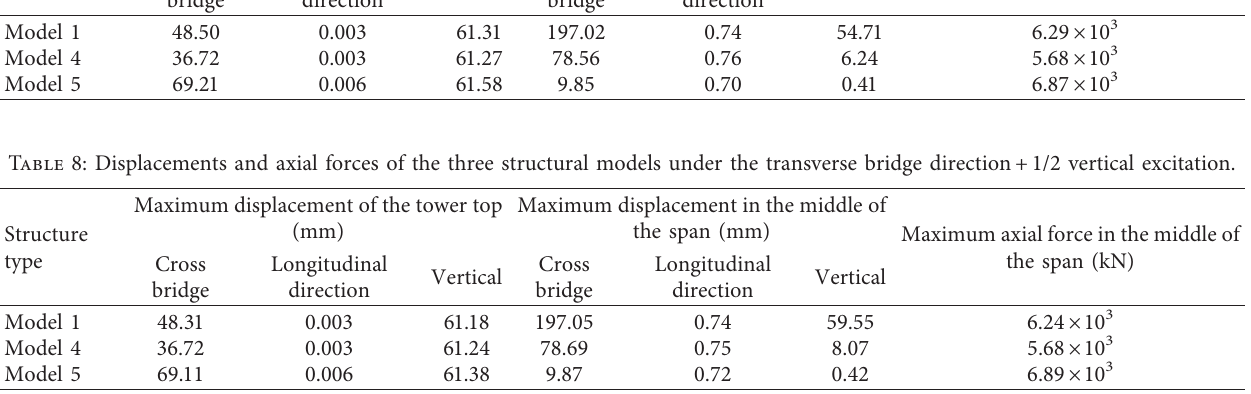
Table 7: Displacements and axial forces of the three structural models under transverse excitation. Maximum displacement of the tower top Maximum displacement in the middle of (mm) the span (mm) Structural model bridge